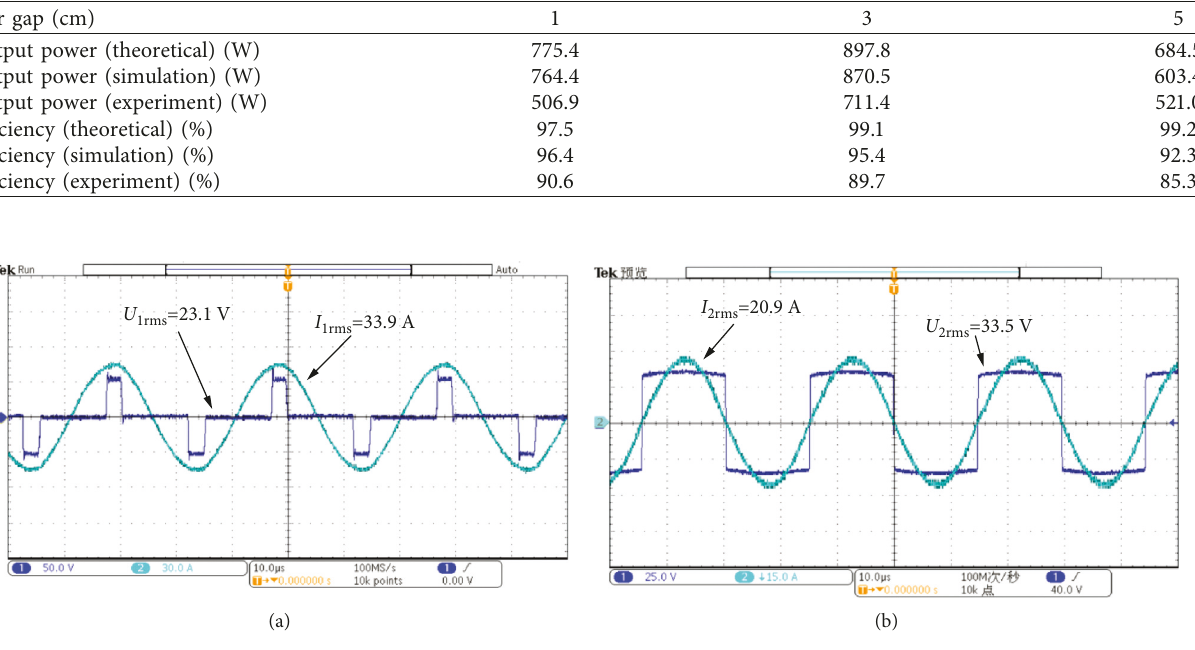
. (a) Primary coil voltage waveform and Ω